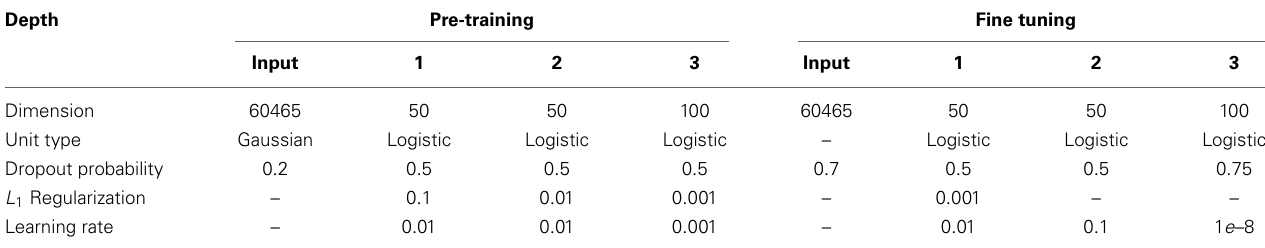
Table 1 | Parameter settings for training RBMs at the pre-training and for the feed forward networks at the discriminative fine-tuning. Depth